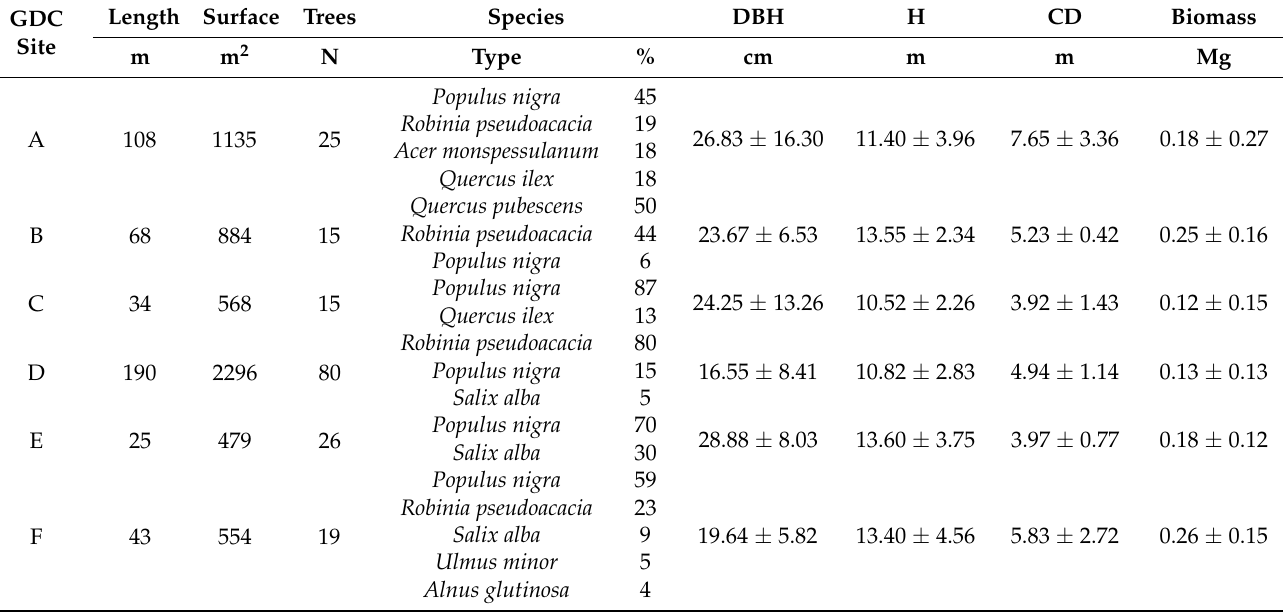
Table 2. Main features of the test sites and ground-collected allometric